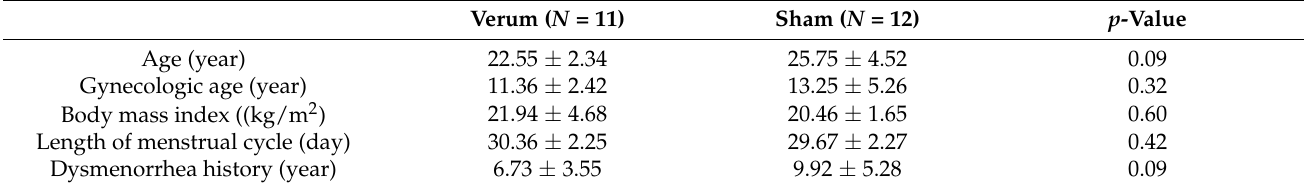
Table 1. The demographic information in both groups. All data are presented as men ± SD.